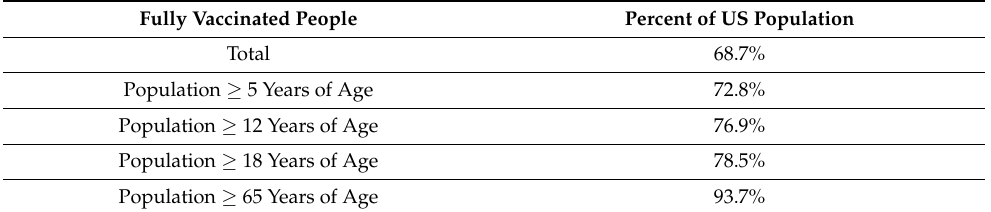
Table 1. COVID-19 Vaccination status in the United States as per CDC records who have completed their primary vaccination series.